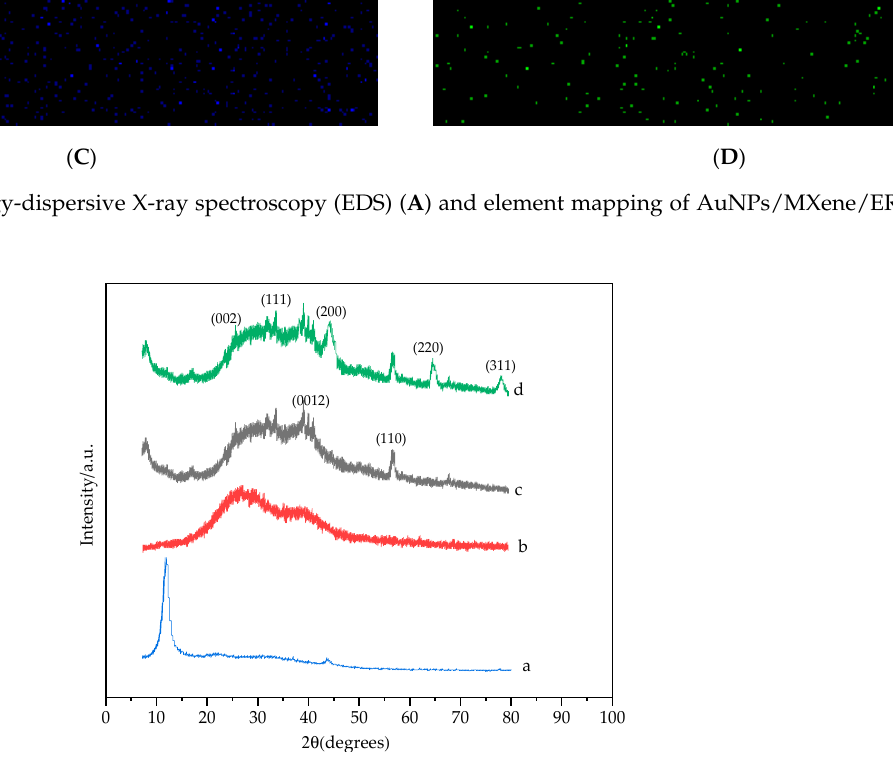
Figure 3. X-ray diffraction (XRD) patterns of GO (a), ERGO (b), MXene/ERGO (c) and AuNPs/MXene/ERGO (d).